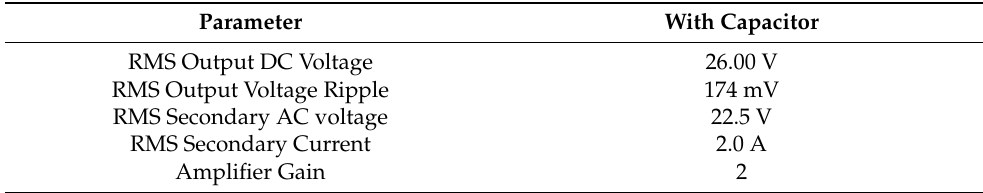
Table 2. Measurements for full-wave